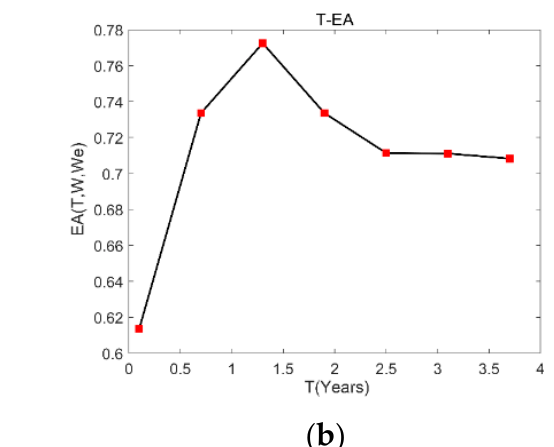
Figure 10. Dimension reduction analysis when We and Ue were fixed. ( a ) Warranty cost as a function of preventive maintenance interval. ( b ) Availability as a function of preventive maintenance interval.